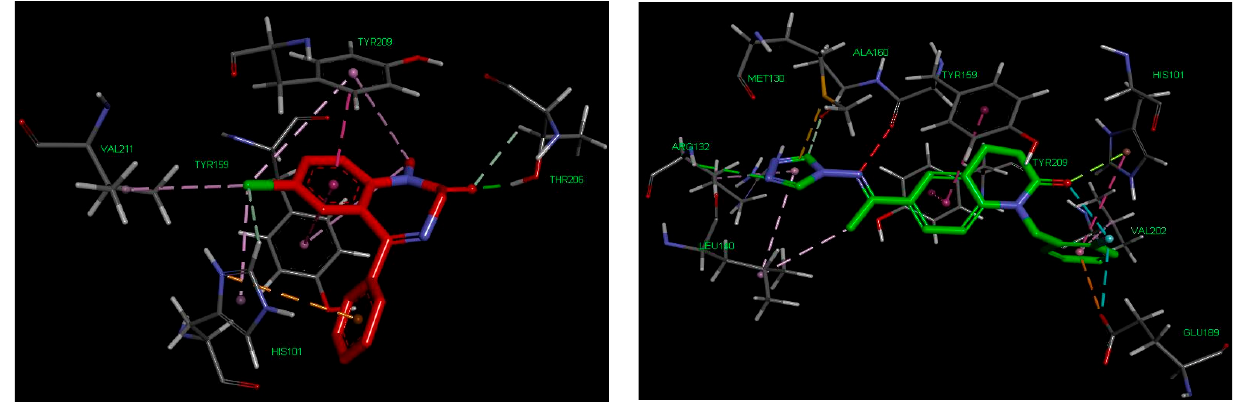
Molecules 2023 , 28 , x FOR PEER REVIEW Figure 8. Interactions between compound 3g (green), diazepam (red), and amino acid residues at the active site of the GABA A receptor.